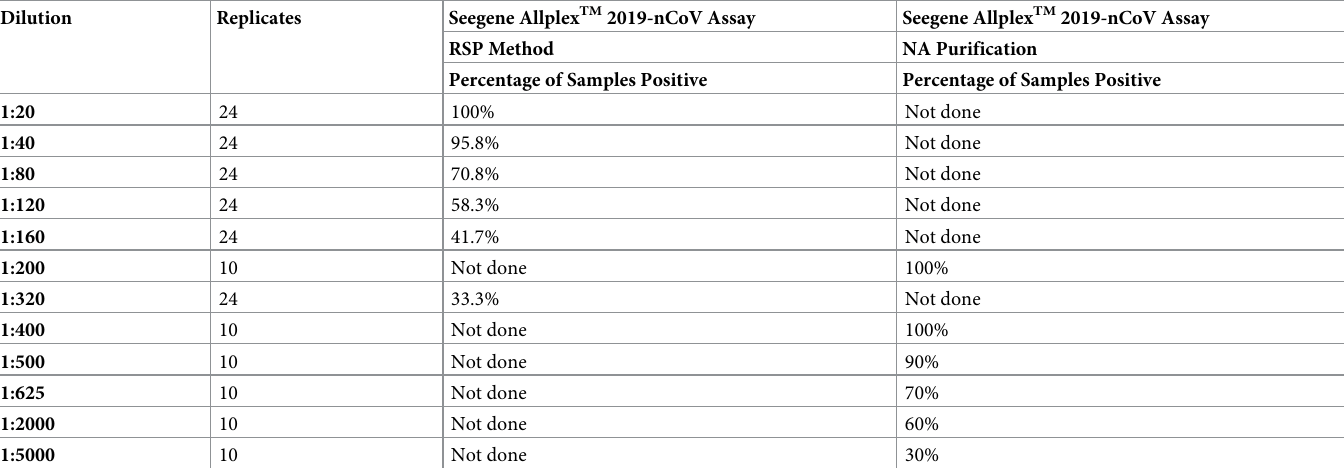
Table 3. Relative analytical sensitivity